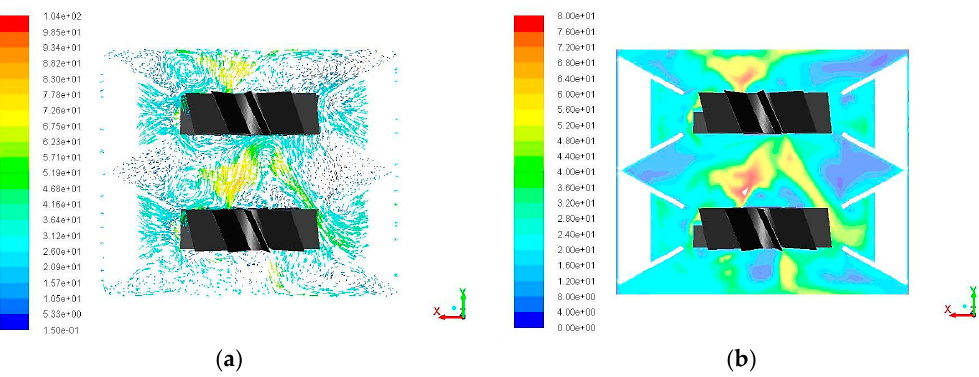
Figure 16. ( a ) Velocity vectors (m/s); ( b ) contours of velocity (m/s) on xy plane and the center of the rotor for two-stage KIONAS, rotor blade angle of 25° and stator with curved guide vanes.